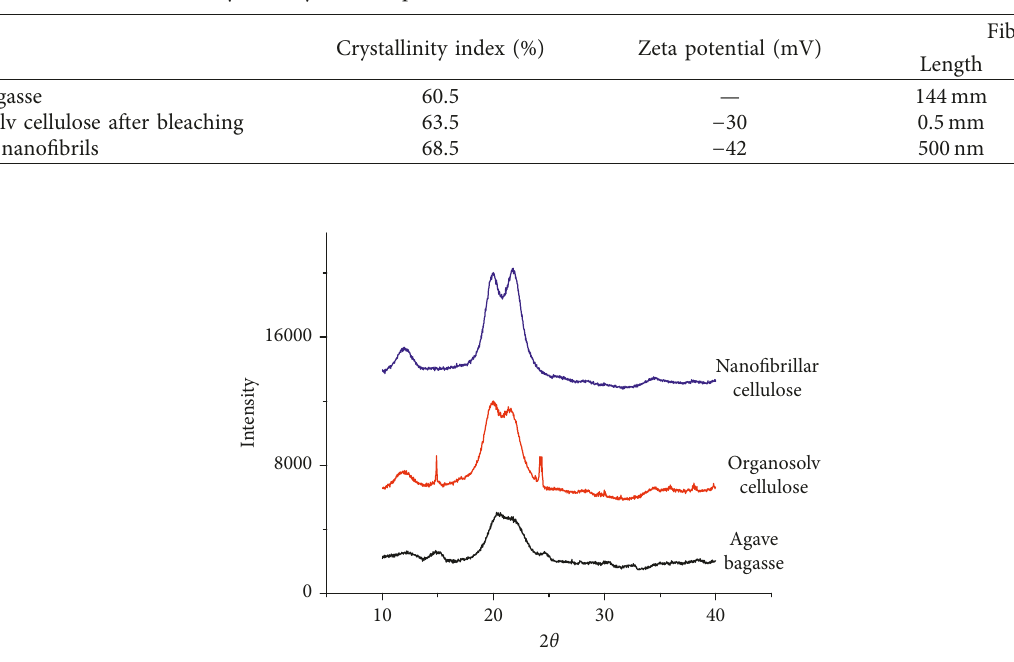
Table 2: Crystallinity index, z potential, and fiber size of the cellulose and nanocellulose.